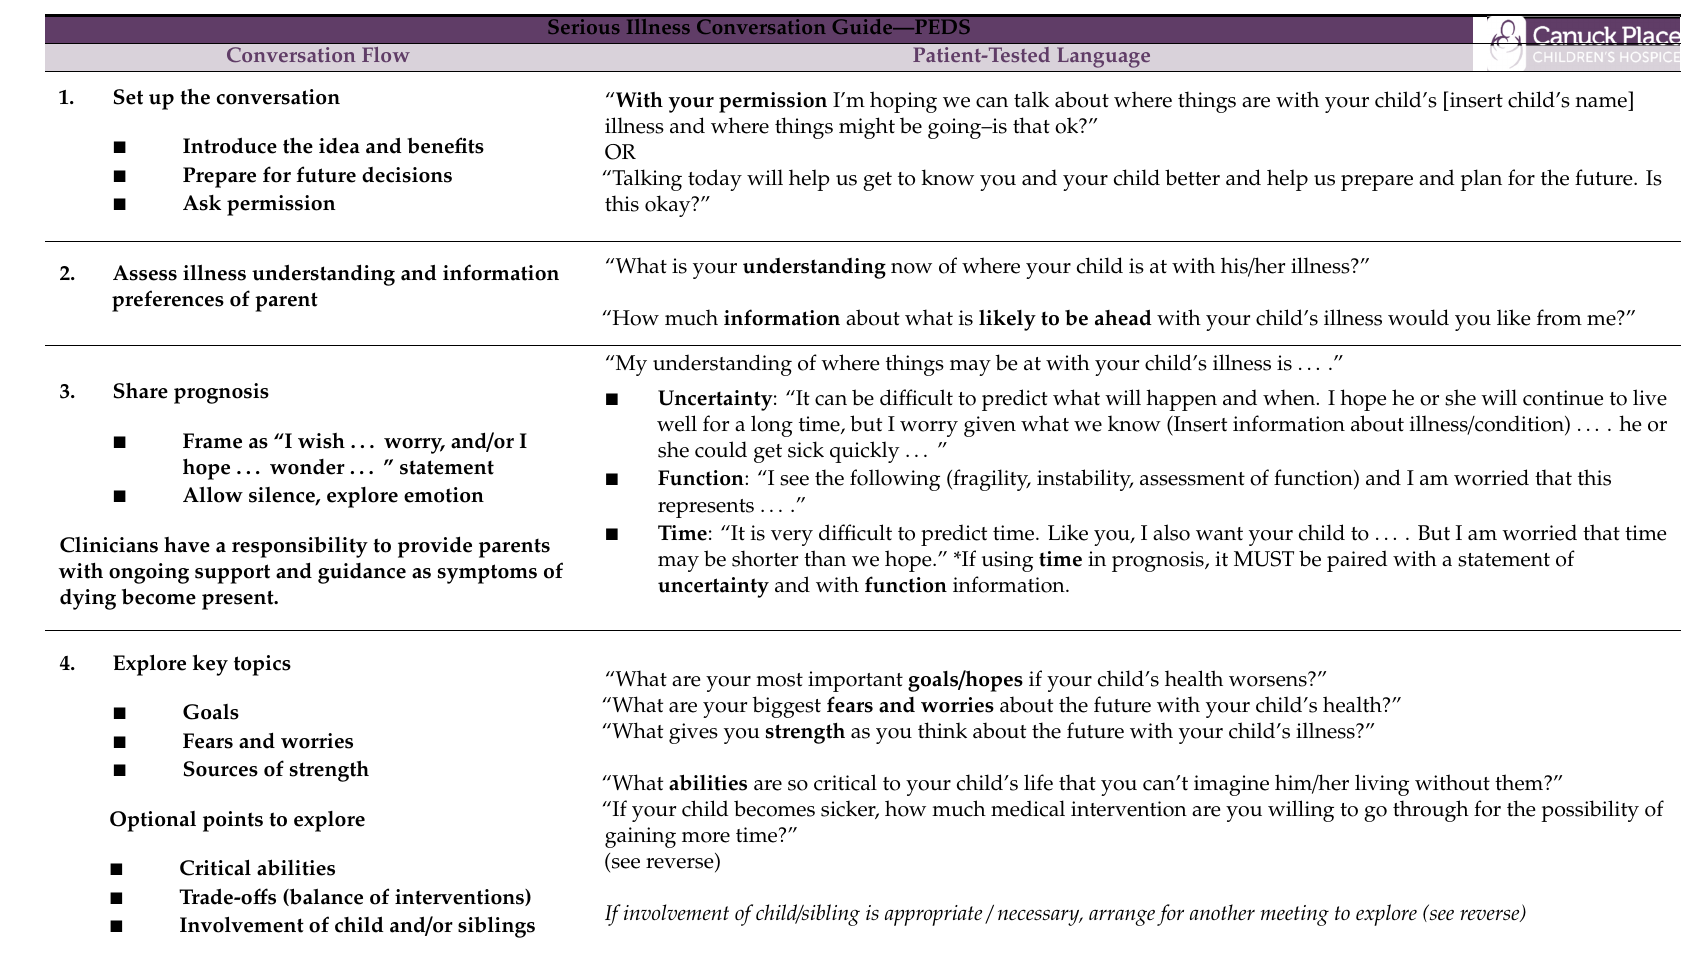
Table A1. Serious Illness Conversation